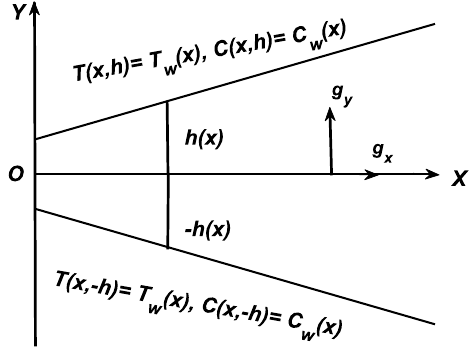
Figure 1. The geometry of the flow problem under